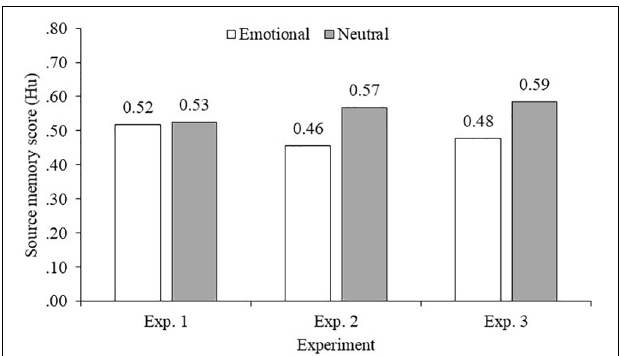
FIGURE 2 | Source memory scores (Hu) collapsed by language for emotional and neutral words in the three